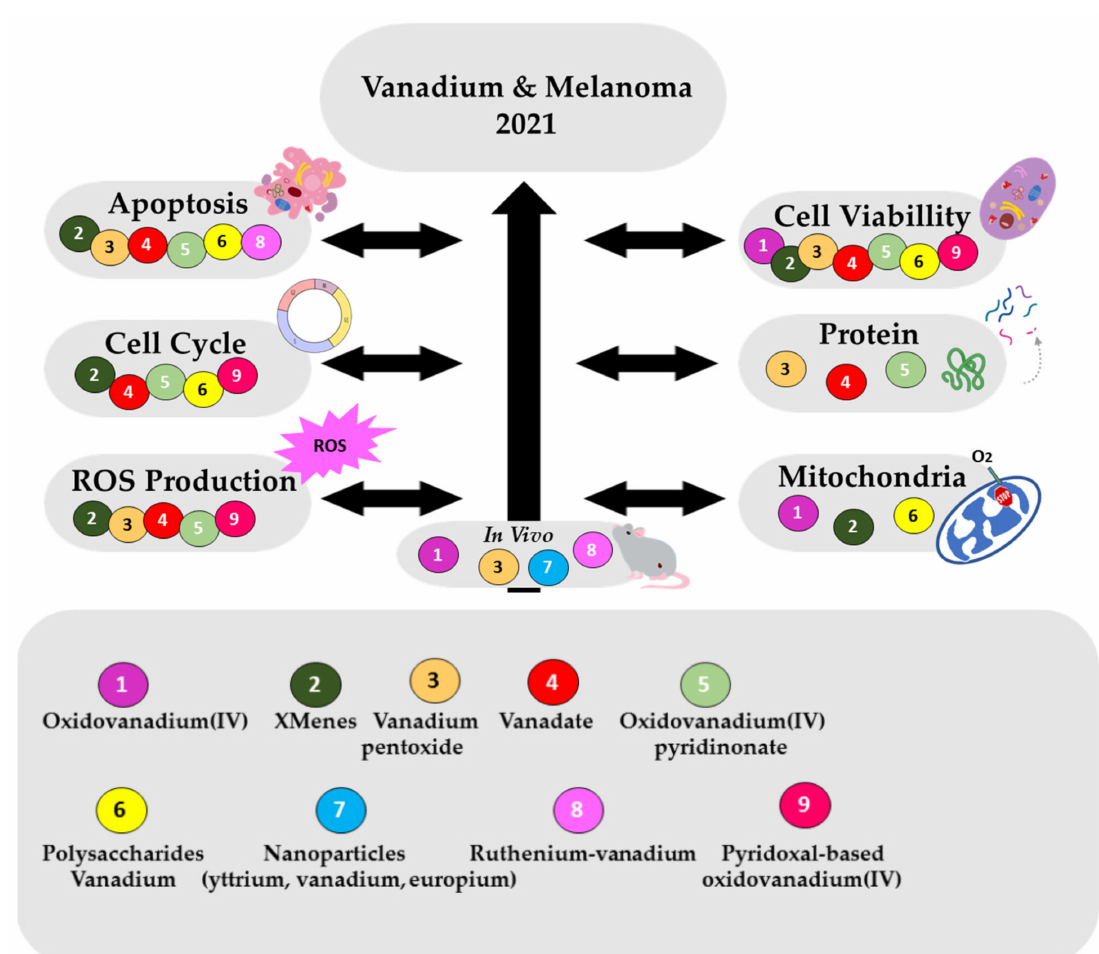
Figure 3. Distribution of the vanadium compounds regarding the effects described in melanoma include: cell viability, apoptosis and morphology changes; cell cycle arrest, ROS production, mitochondria dysfunction; proteins expression and in vivo tumor regression and rate of survival studies. Billiard balls representing the vanadium compounds: (1) oxidovanadium (IV); (2) XMenes; (3) vanadium pentoxide; (4) vanadate; (5) oxidovanadium(IV) pyridinonate compounds; (6) polysaccharides vanadium(IV/V) complexes; (7) functionalized nanoparticles of yttrium vanadate doped with europium; (8) mixed-metal binuclear ruthenium(II)–vanadium(IV) complexes; (9) pyridoxal-based oxidovanadium(IV)